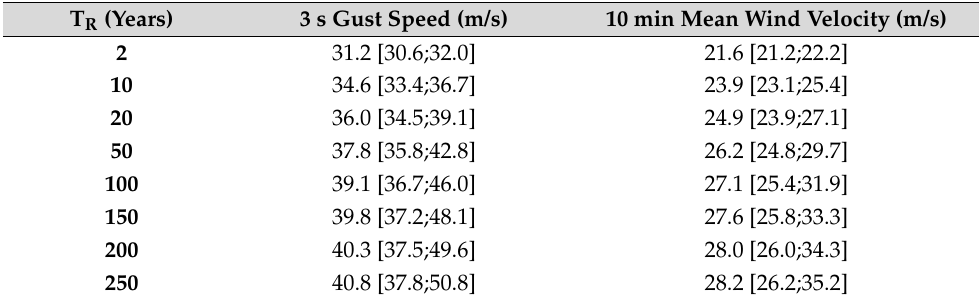
Figure 13. Return level plot for the GPD model fitted to the maximum gust speed at St Mary’s, based on the selected threshold of 27.4 m/s and declustering time window of 72 h. The associated 95% confidence interval is also shown with dashed blue lines. Table 3. Estimates of 3 s gust speed for different return periods (T R , years) and corresponding 10 min mean wind velocity at St